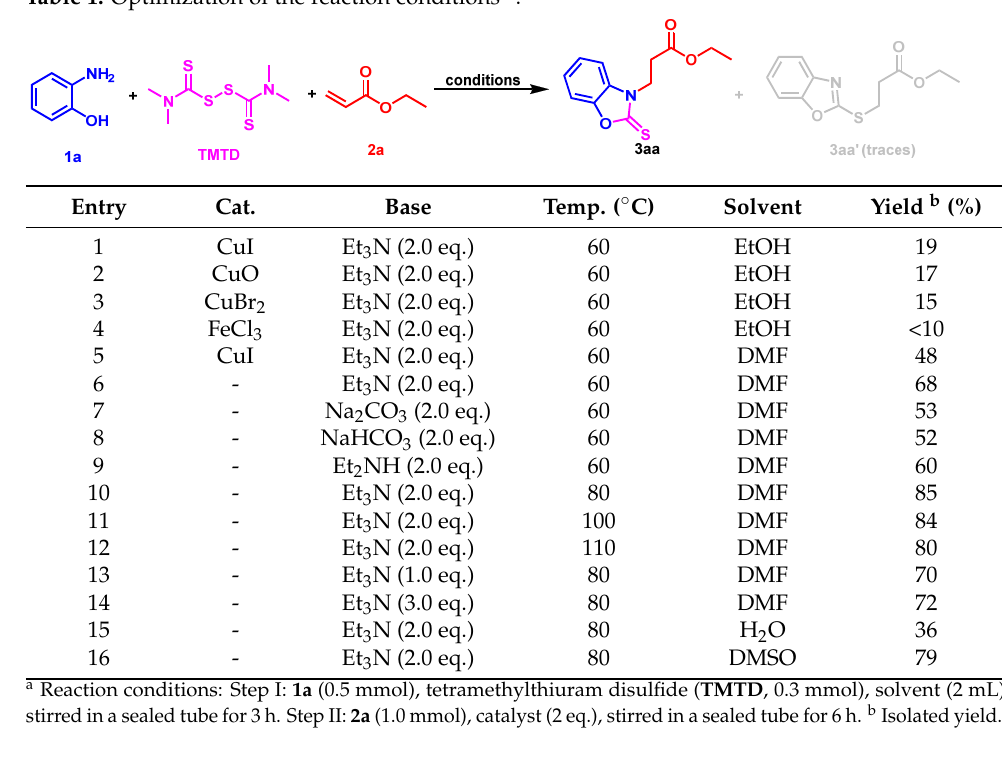
Table 1. Optimization of the reaction conditions a,b .